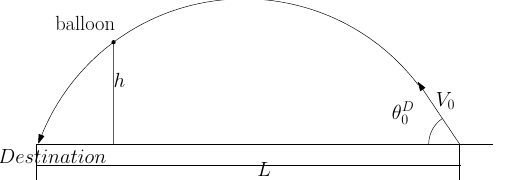
Figure 1. A balloon at height h . The balloon blocks the EP’s path for reaching its